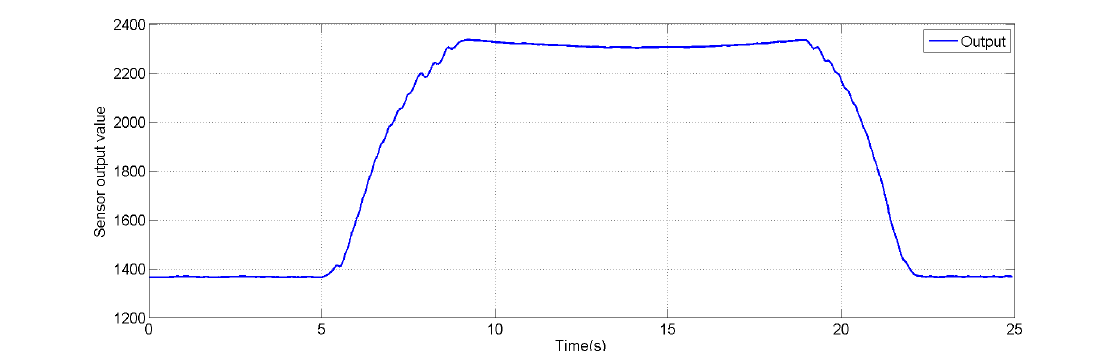
Figure 14. Single sensor output response. Its behavior is purely linear; no hysteresis effect was